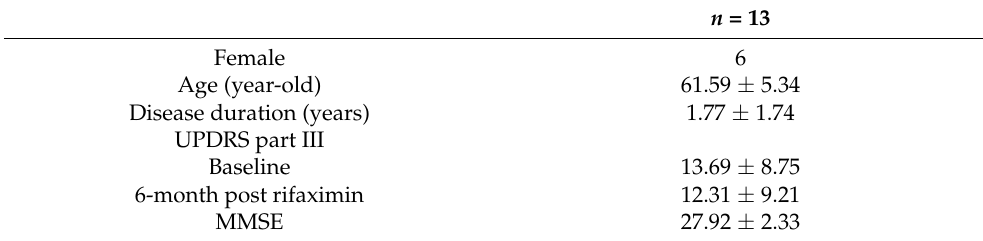
Table 1. Demographic data of study participants. The demographic data of 13 PD patients who were analyzed. Data are presented as mean ± standard deviation for continuous